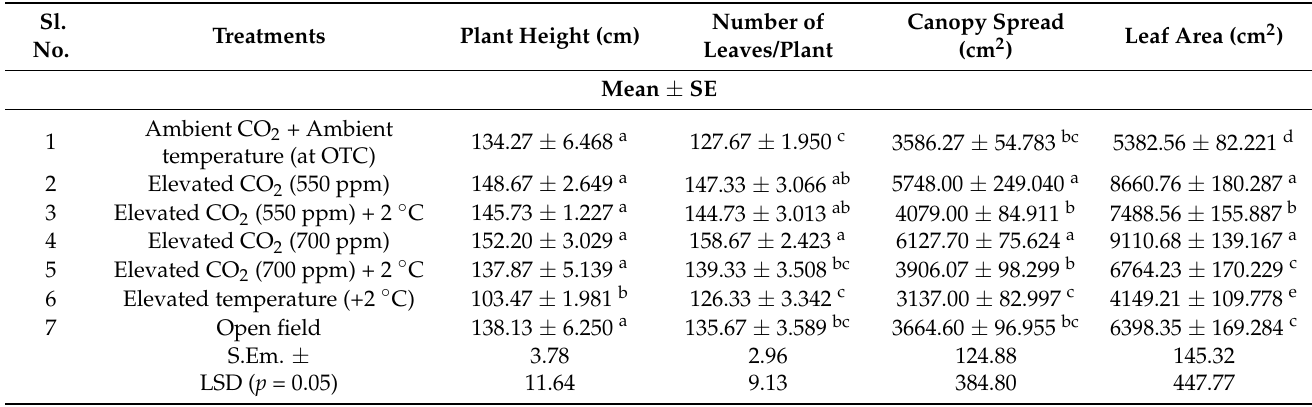
Table 1. Plant height (cm), number of leaves per plant, canopy spread (cm 2 ) and leaf area (cm 2 ) of tomato as influenced by elevated CO 2 and temperature